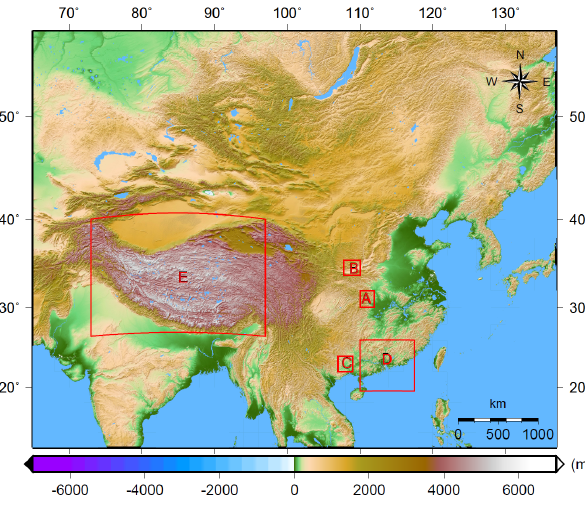
Figure 1. Locations of the study areas over China, plotted on a shaded relief map from GTOPO30 data (copyright by USGS: www1.gsi.go.jp/geowww/globalmap-gsi/gtopo30/gtopo30.html). A=Three Gorges area; B=Xi’an area; C=Nanning area; D= Guangdong area; E=Tibetan plateau.